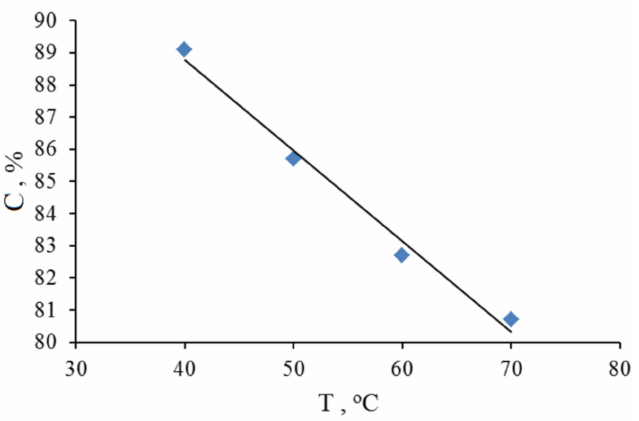
Figure 1. The dependence of the 0 conversion (C) on the reaction temperature T. At T = 0 ◦ C, the copper complex completely dissolved, and all 0 white flakes floated to the surface of the blue-green acetonitrile solution. At T = 20 ◦ C, the taken amount of 0 was completely soluble, but oxidation was not carried out at this temperature. The maximum value of C, which, as it turned out, should have been at T less than 40 ◦ C, and not more, was not